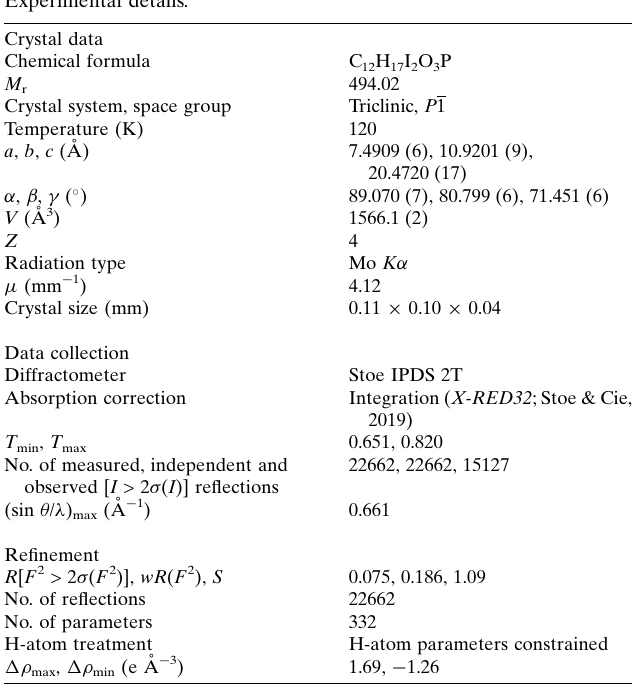
Table 2 Experimental details.